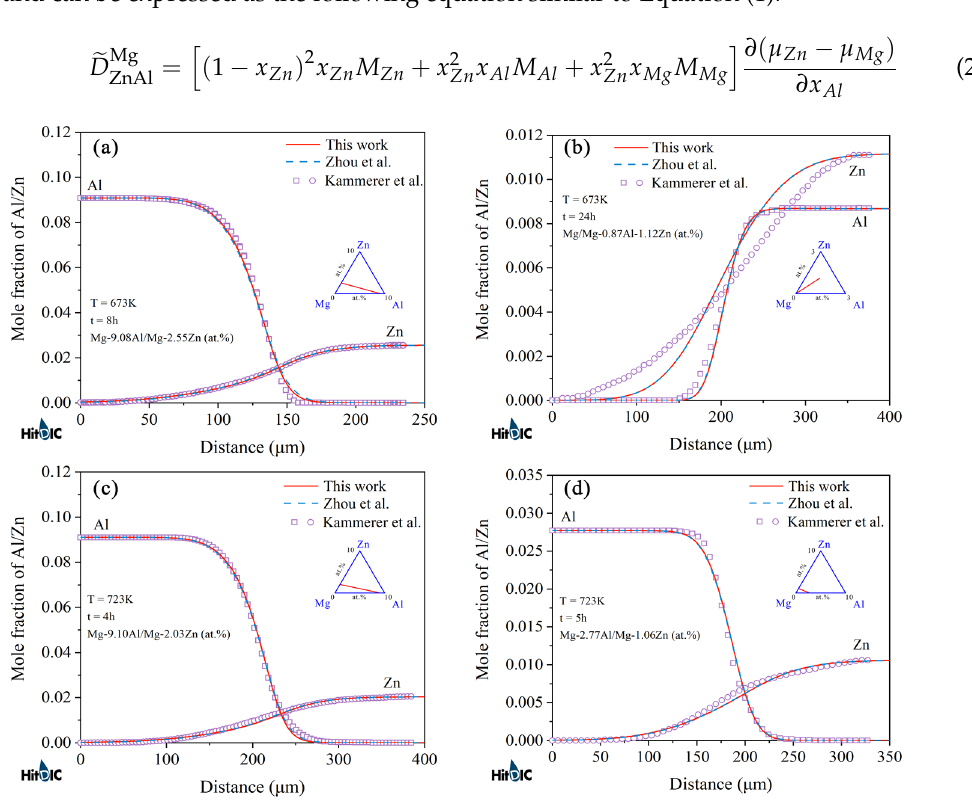
Figure 2. Model-predicted composition–distance profiles of different hcp Mg–Al–Zn diffusion couples annealed at ( a ) 673 K for 8 h, ( b ) 673 K for 24 h, ( c ) 723 K for 4 h, and ( d ) 723 K for 5 h, due to the present atomic mobilities (solid lines), compared with those of Zhong et al. [32] (dashed lines) and the experimental data [35] (in